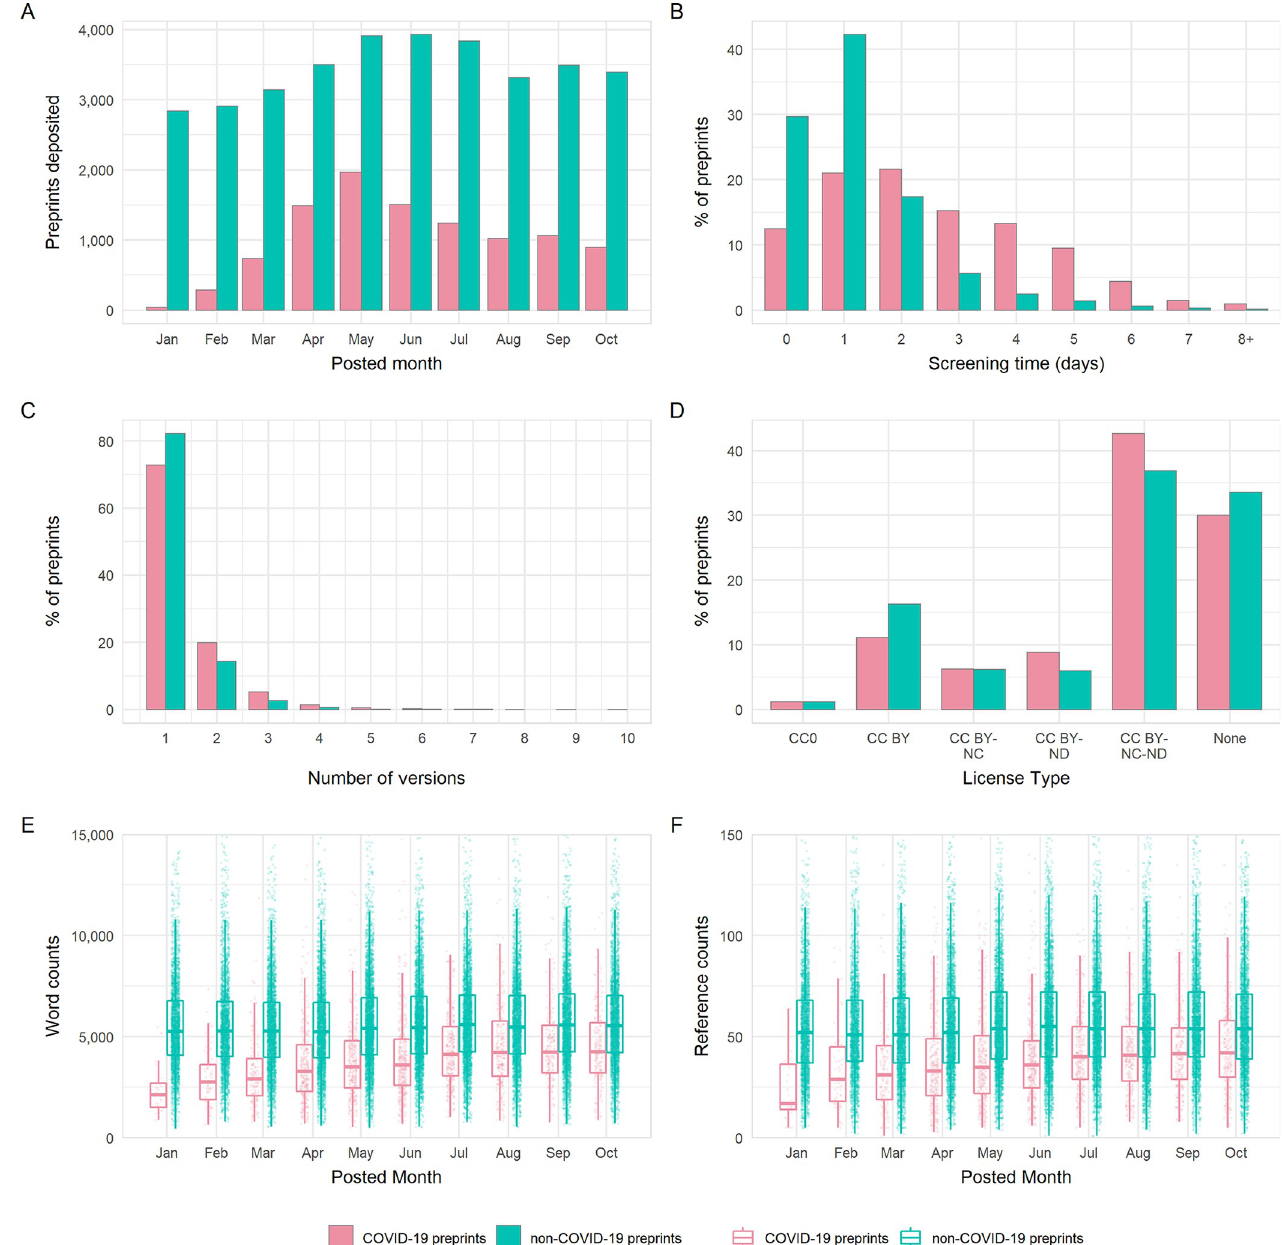
Fig 2. Comparison of the properties of COVID-19 and non-COVID-19 preprints deposited on bioRxiv and medRxiv between January 1 and October 31, 2020. (A) Number of new preprints deposited per month. (B) Preprint screening time in days. (C) License type chosen by authors. (D) Number of versions per preprint. (E) Boxplot of preprint word counts, binned by posting month. (F) Boxplot of preprint reference counts, binned by posting month. Boxplot horizontal lines denote lower quartile, median, upper quartile, with whiskers extending to 1.5 � IQR. All boxplots additionally show raw data values for individual preprints with added horizontal jitter for visibility. The data underlying this figure may be found in https://github.com/preprinting-a-pandemic/ pandemic_preprints and https://zenodo.org/record/4587214#.YEN22Hmnx9A. COVID-19, Coronavirus Disease 2019.